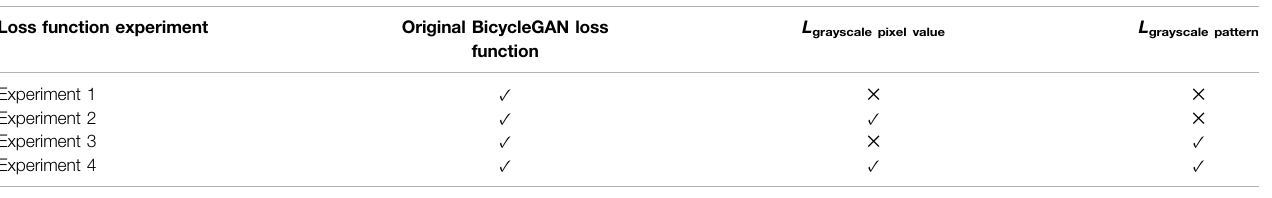
TABLE 2 | Loss function comparison experiment.